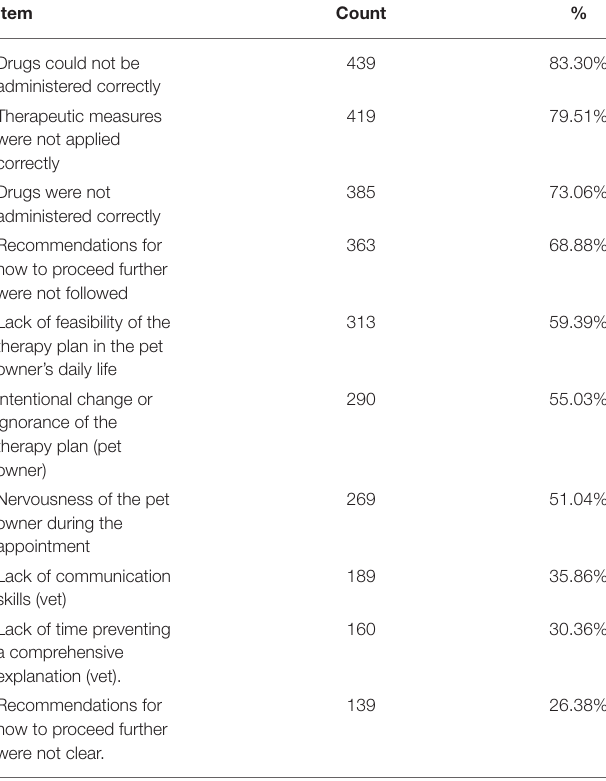
TABLE 1 | Associations between the questionnaire items/factors and age and gender.